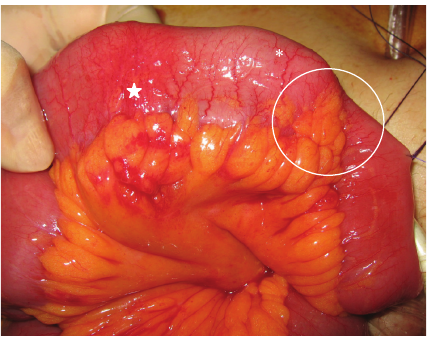
Figure 3: Operative findings. Retained CE capsule ( ∗ ). Reddened serosa (star). Stenosis with the wrapping-sign and caliber change (inside the